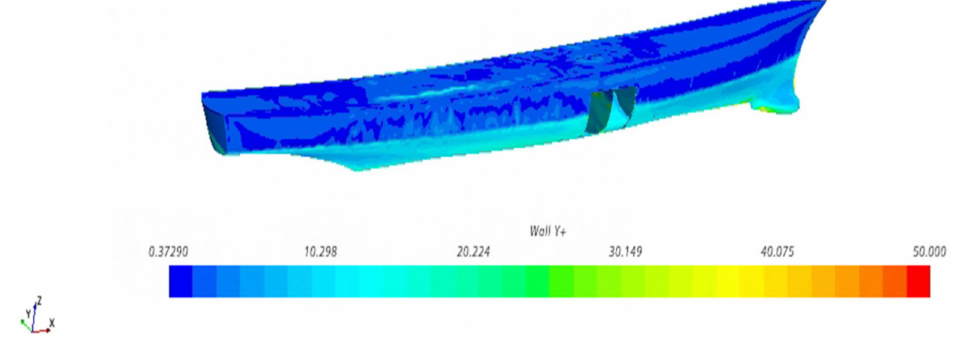
Figure 8. Y + values on the hull surface.